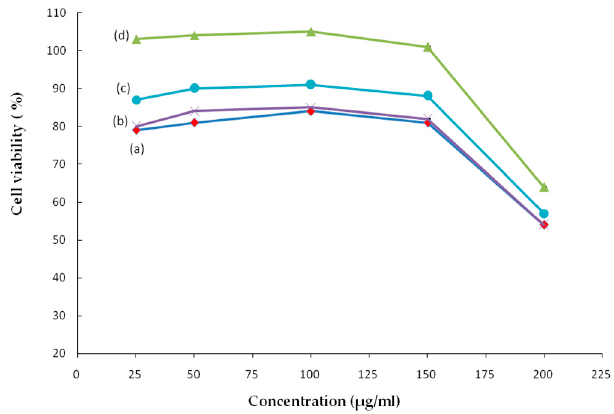
Figure 4. Effect of samples at different concentrations on L929 cell viability: (a) CMC, (b) CMC – COP12, (c) CMC – COP26, and (d) CMC – COP58.